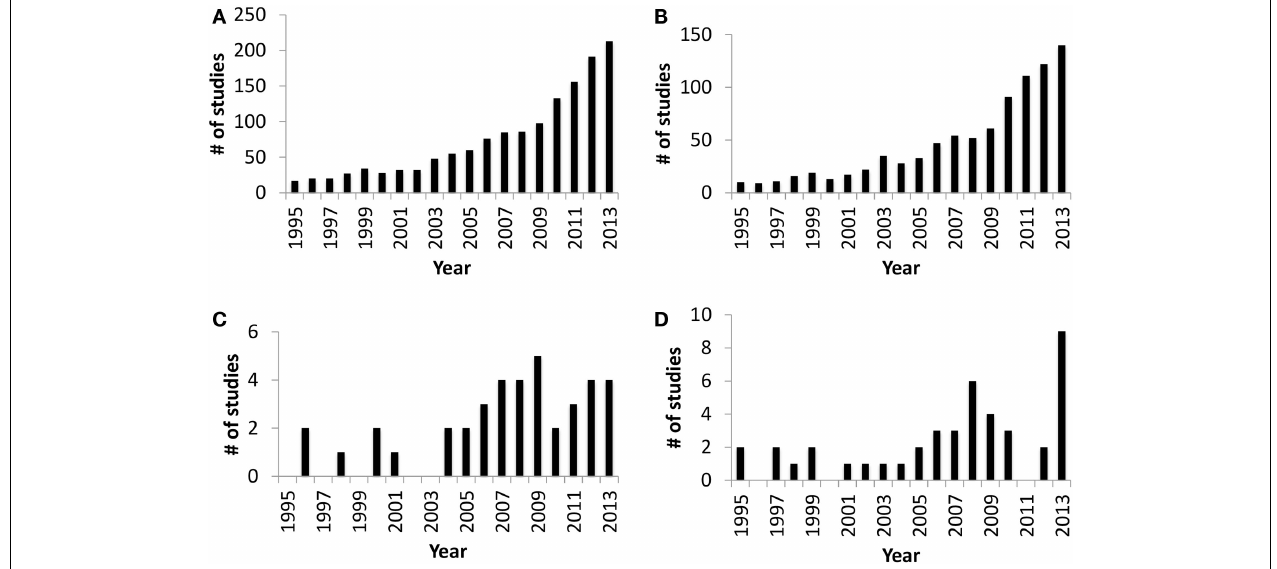
FIGURE 1 | Number of publication entries in Medline (PubMed) trend* from 1995 to 2013 . (A) Publication entries searched with query “gut colonization.” (B) Publication entries searched with query “gut colonization and human.” (C) Publication entries searched with query “gut colonization and ruminant.” (D) Publication entries searched with query “rumen colonization.” *Medline Trend, URL: